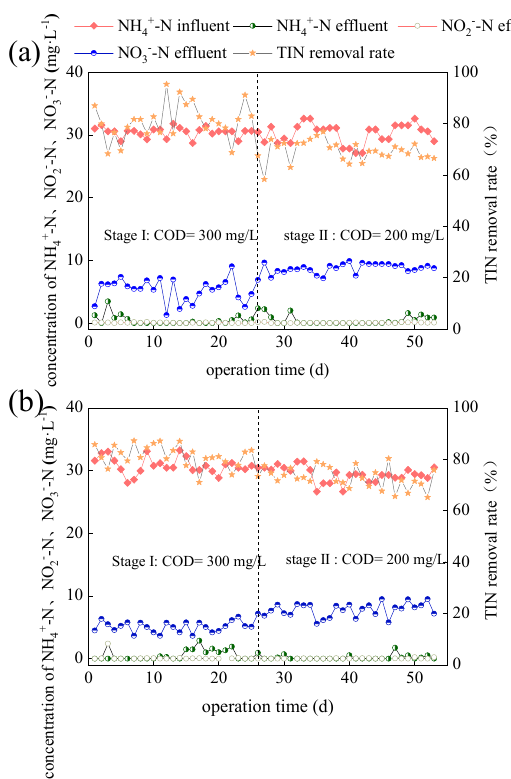
Figure 2. Variations of influent NH + -N, effluent NH 4+ -N, NO 2 − -N and NO 3 − -N and TIN removal efficiency under different COD in influent (( a ): 100kPa, ( b ): 72 kPa).